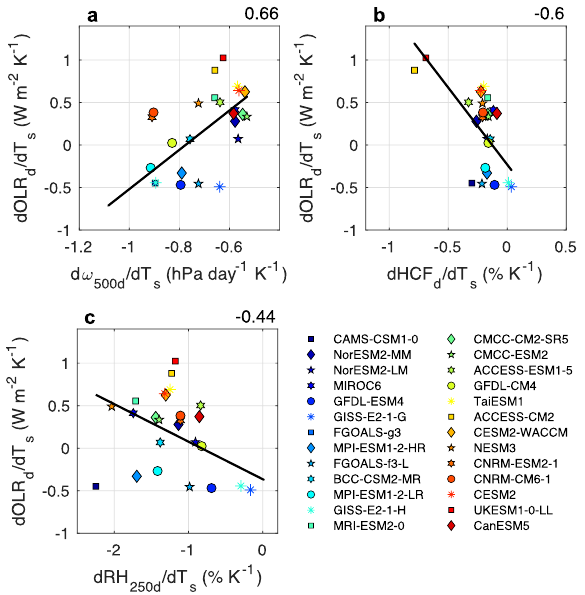
Fig. 6 | A lesser reduction of subsidence corresponds to a greater increase in outgoinglongwaveradiation,whichislinkedtodecreasedhighcloudfraction and upper tropospheric relative humidity. The relationships between ( a ) chan- ges in subsidence rate (d ω 500d /dT s ; hPa day − 1 K − 1 ) and changes in descent region outgoing longwave radiation (dOLR d /dT s ; W m -2 K − 1 ), ( b ) changes in the descent region high cloud fraction (dHCF d /dT s ; % K − 1 ) and dOLR d /dT s , and ( c ) changes in descent region upper tropospheric relative humidity (dRH 250d /dT s ; % K − 1 ) and dOLR d /dT s for 26 CMIP6 models. The color scale from blue to red re fl ects increasing equilibrium climate sensitivity (ECS) values. All relationships shown are tropical averages (30°S-30°N) including both land and ocean points. Changes are calculated as the differences between 2086 – 2100 (SSP5-8.5) and 2000 – 2014 (his- torical). Values in the upper right are Pearson correlation coef fi cients for the regression lines shown. All relationships are statistically signi fi cant at the 95% con fi dence